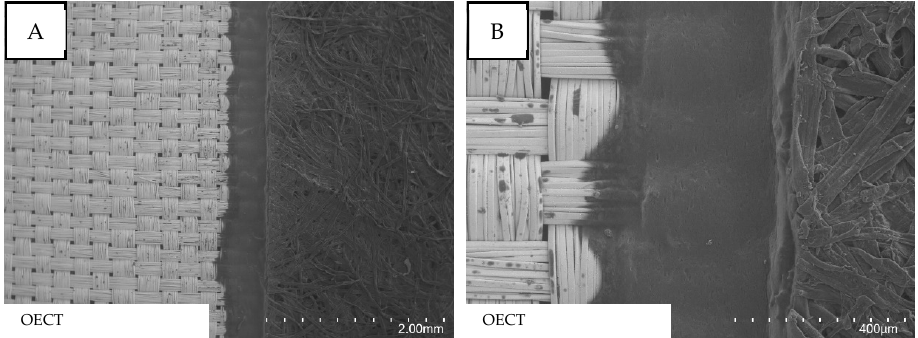
Figure 5. SEM images showing the layered structure of the readily assembled OECT. ( A ): 25 times magnification. ( B ): 120 times magnification.